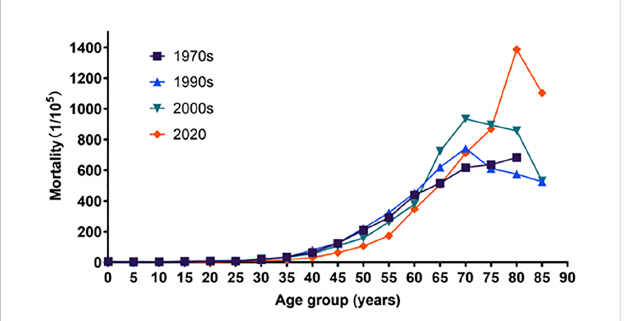
FIGURE 7 Age-speci fi c mortality rates of cancer during four periods in female, trends of Chi-square of the 1970s, the 1990s, the 2000s, and 2002 were 19,043.474, 1,633.955, 2,013.222, and 14,508.884, respectively. All P-values were less than 0.05.